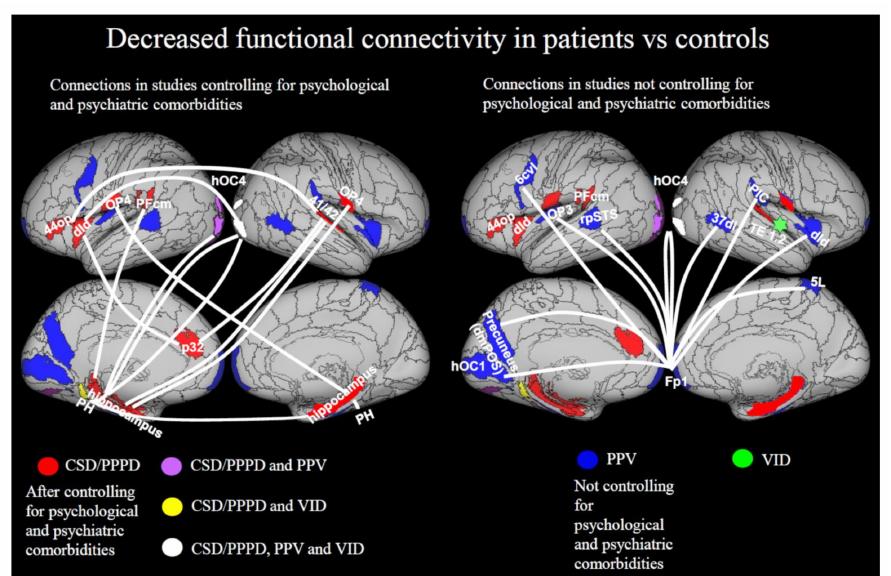
Figure 4. Reduced functional connectivity. In the left panel, we report decreased connectivity after controlling for possible effects of psychiatric comorbidities. After this control, Lee et al. [42] found decreased connectivity in PPPD vs. controls between the left hippocampus and: (1) right central opercular cortex (OP4), (2) bilateral associative cortex (hOC4), (3) left parietal opercular cortex (PFcm). They also showed decreased connectivity between the right hippocampus and: (1) bilateral parahippocampal gyrus, (2) left central opercular cortex (OP4). Indovina et al. [39] found decreased connectivity in CSD/PPPD vs. controls in response to sound-evoked vestibular stimulation between the right superior temporal gyrus (BA 41/42) and: (1) the left hippocampus, (2) the left dId/44 op and (3) left ACC (32p). They also found decreased connectivity between the left dId/44 op and right visual associative cortex (hOC4). Van Ombergen et al. [36] found decreased connectivity of the right central opercular region (TE1.2) with the rest of the brain in patients with VID vs. controls (represented with a star). They also found decreased connectivity between right visual associative cortex (hOC4) and left parahippocampal/temporal fusiform gyrus (PH). In the right panel, we report decreased connectivity in analyses not controlling for possible effects of psychiatric comorbidities. In this analysis, Popp et al. [48] found decreased connectivity in response to visual motion between fpPFC and: (1) right middle temporal gyrus (37dl), (2) bilateral precuneus (right 5 L, left dorso- medial parieto-occipital sulcus = dmPOS), (3) bilateral visual associative cortex (hOC4), (4) right fronto-polar cortex (FP1), (5) left primary visual cortex (hOC1), (6) right PIC, (7) left rpSTS, (8) left parietal operculum (OP3), (9) right dId, (10) left FP1, (11) left 6 cvl. Regions from CSD/PPPD are in red, regions from PPV are in blue, regions from VID are in green. Regions in common between CSD/PPPD and VID are in yellow; regions in common between PPPD and PPV are in purple; regions in common between CSD/PPPD, PPV and VID are in white. Regions from the Anatomy atlas [52] and Brainnetome atlas [53] are overlapped onto the Conte69 inflated brain in workbench viewer